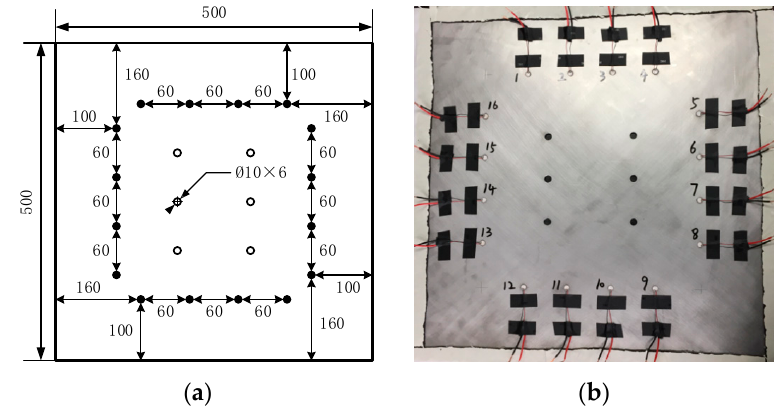
Figure 8. ( a ) The diagram of the layout of the piezoelectric sensor network and ( b ) the real layout of piezoelectric sensor network (unit: mm).